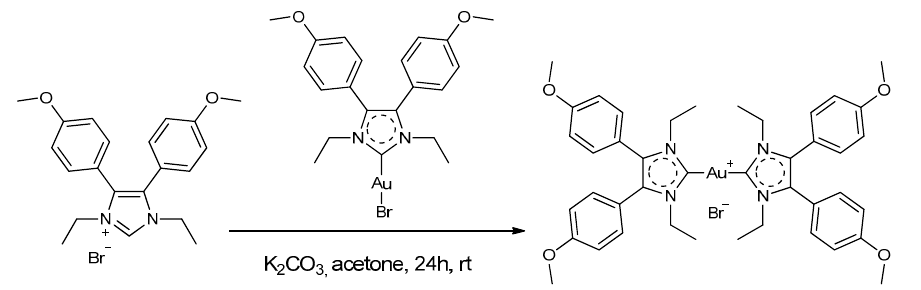
Figure 2. Scheme of synthetic route of Au4BC.